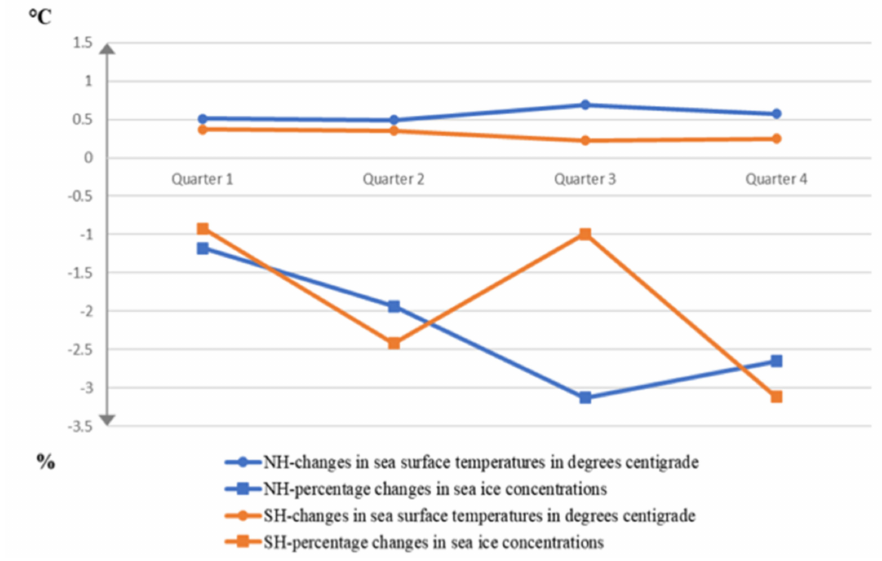
Figure 1. Changes in sea surface temperatures and sea ice concentrations between 2000 and 2019 in the four quarters in the Northern and Southern hemispheres using data for 1 × 1 degree